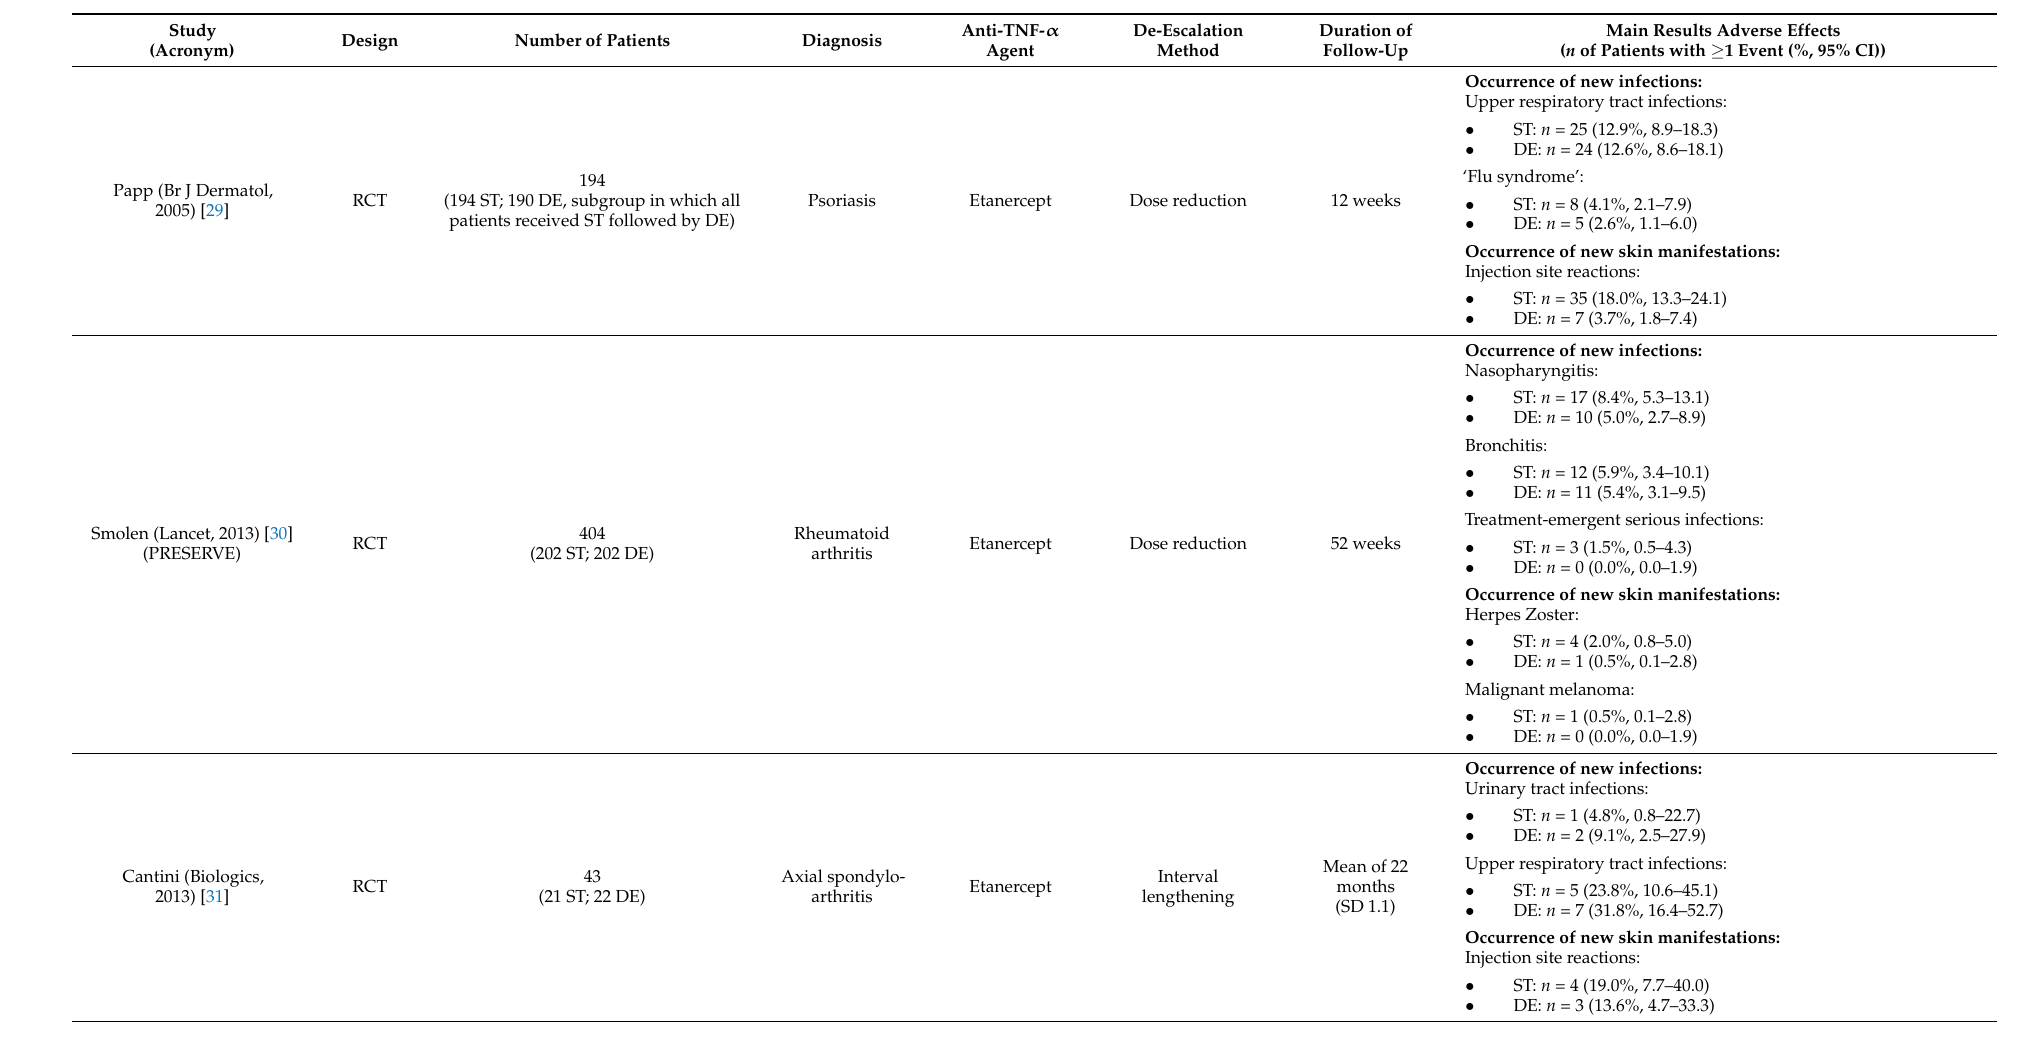
Table 1. Characteristics and main results of included